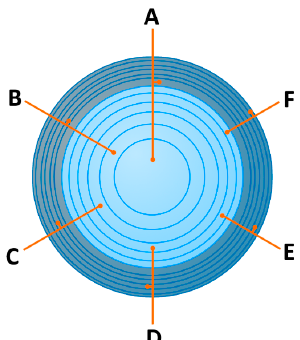
Figure 12. Design principle of a diffractive lens. The lens has multiple electrode domains, each with their own sub-domains. Each domain is equivalent to each concentric zone in a Fresnel plate. The sub-domains are used to radially vary the potential so transmitted light is diffracted. Therefore, each sub-domain is wired to its successive equivalent in the larger domains [6].